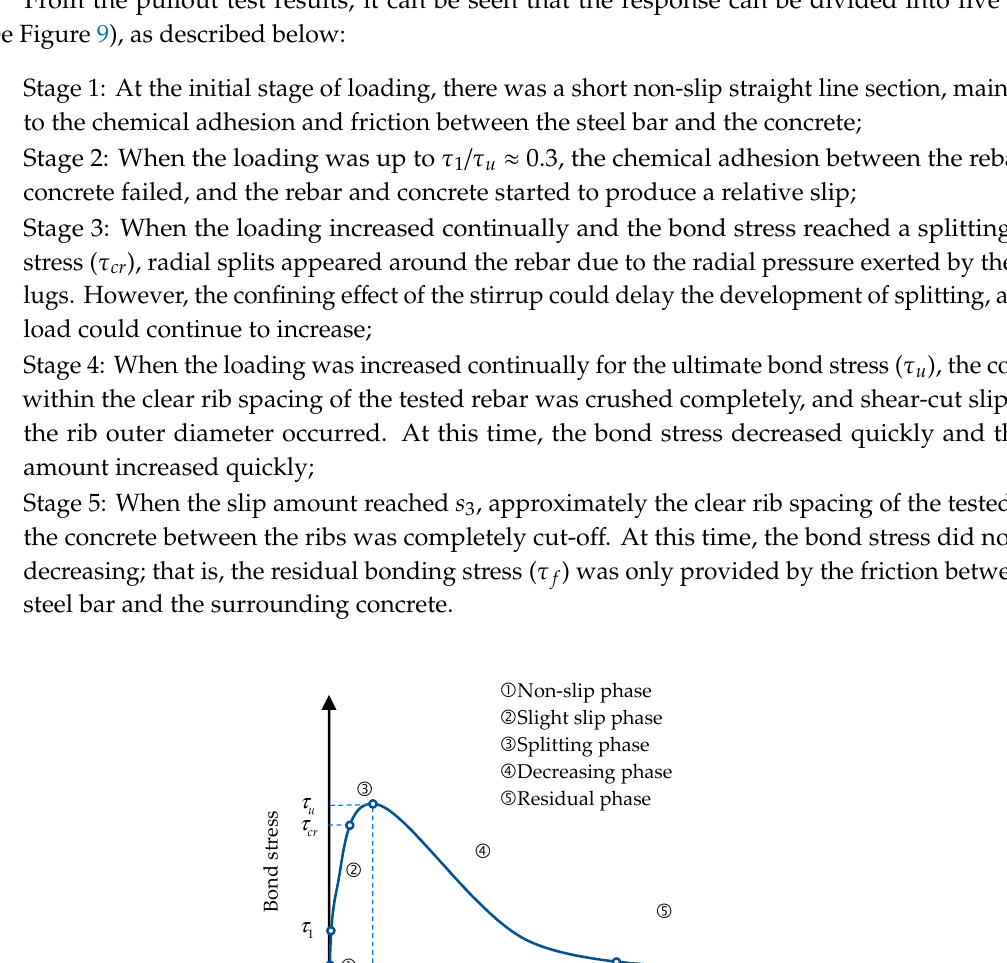
Figure 9. Typical local bond stress–slip curve.